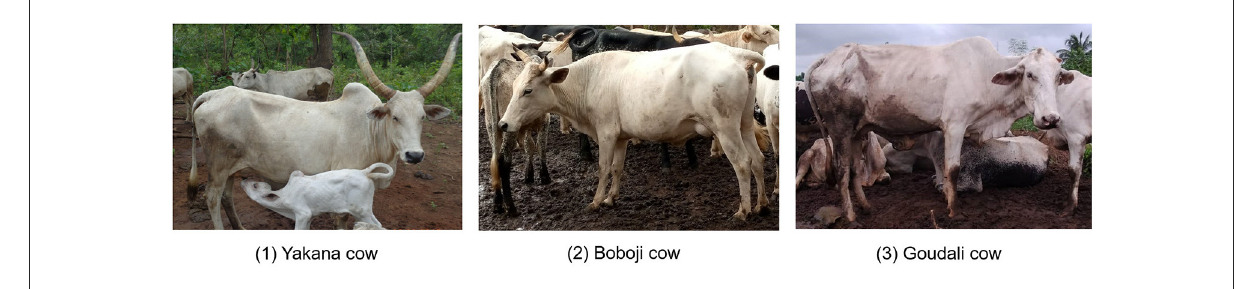
FIGURE2 Cow breeds in the peri-urban dairy cattle farms of South Benin.